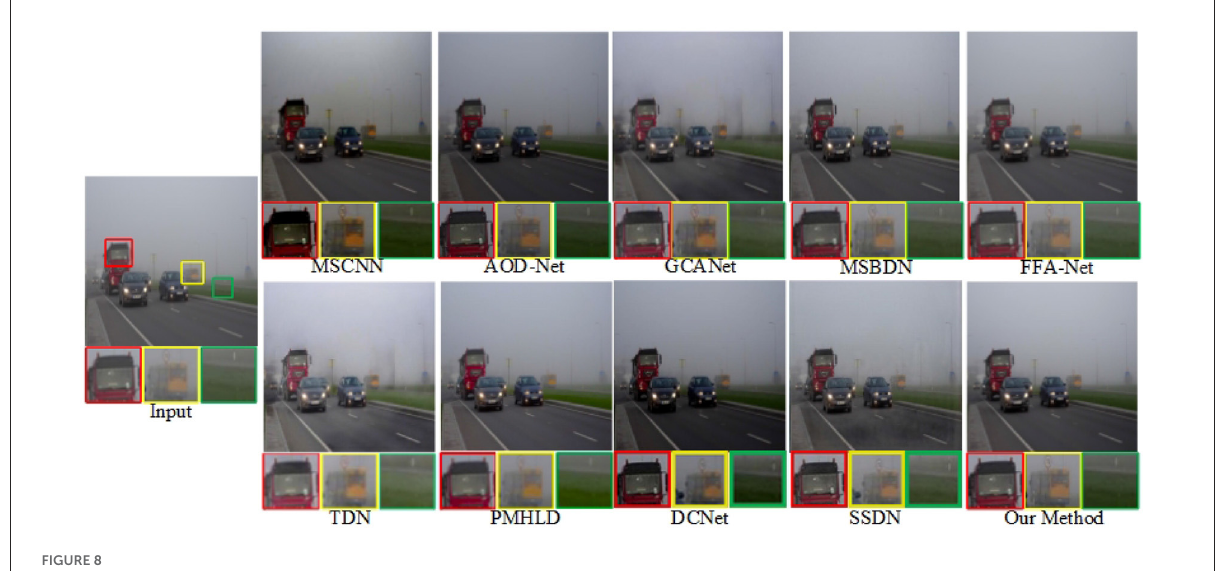
FIGURE8 Visual quality comparison on real dense fog images.